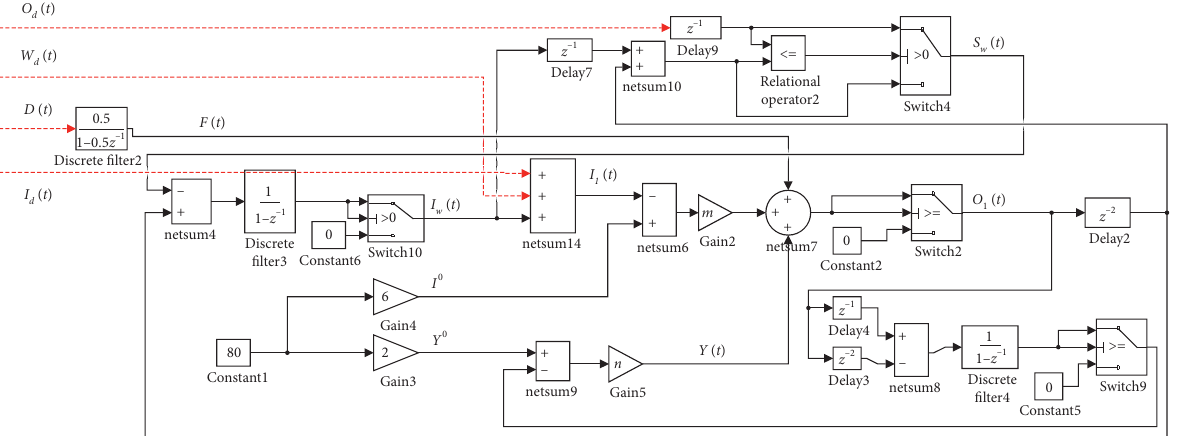
Figure 4: The block diagram of production and warehouse systems from the local decision perspective.